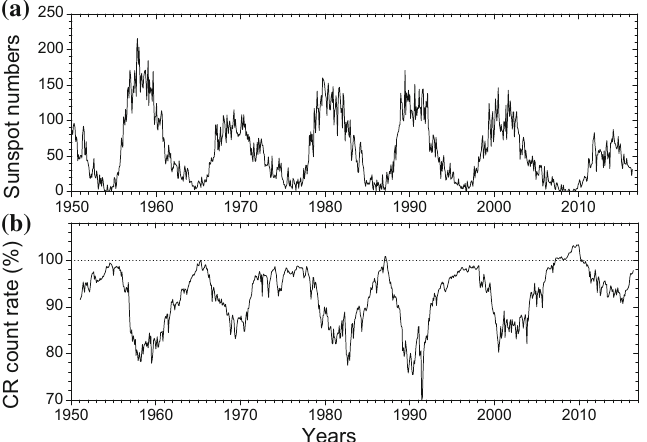
Fig. 4 Cyclic variations since 1951. a Time profiles of International sunspot number v.2 (scaled with 0.6- factor) (http://sidc.be/silso/datafiles); b cosmic-ray flux as the count rate of a polar neutron monitor (Oulu NM http://cosmicrays.oulu.fi, Climax NM data used before 1964), 100% NM count rate corresponds to May